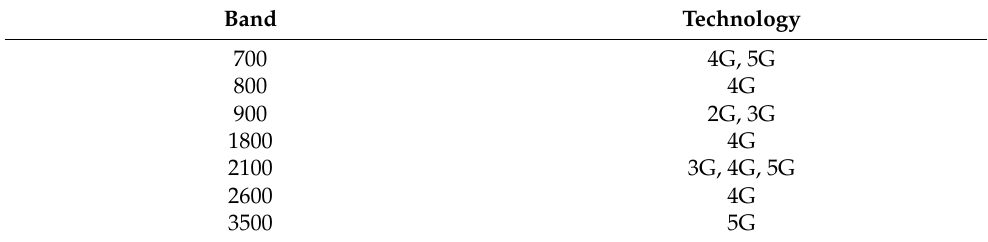
Table 1. Frequency bands utilized by different mobile communication technologies.